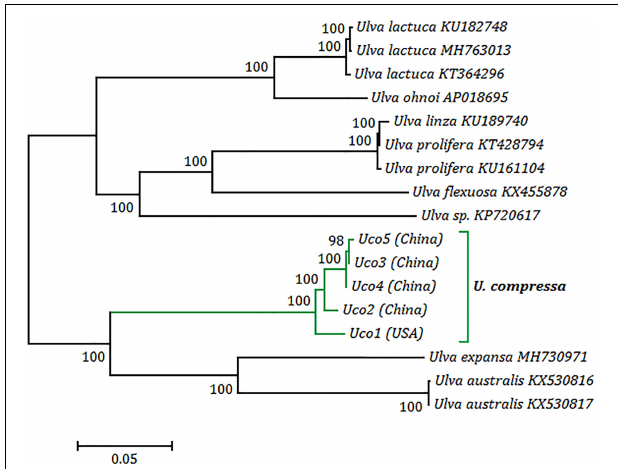
FIGURE 7 | Phylogenomic tree based on Maximum Likelihood (ML) analysis of nucleotide sequences of 17 Ulva mitogenomes. The ML analysis was conducted with 1,000 bootstrap replicates using MEGA 7.0. Branch lengths were proportional to the amount of sequence change, which were indicated by the scale bar below the trees.